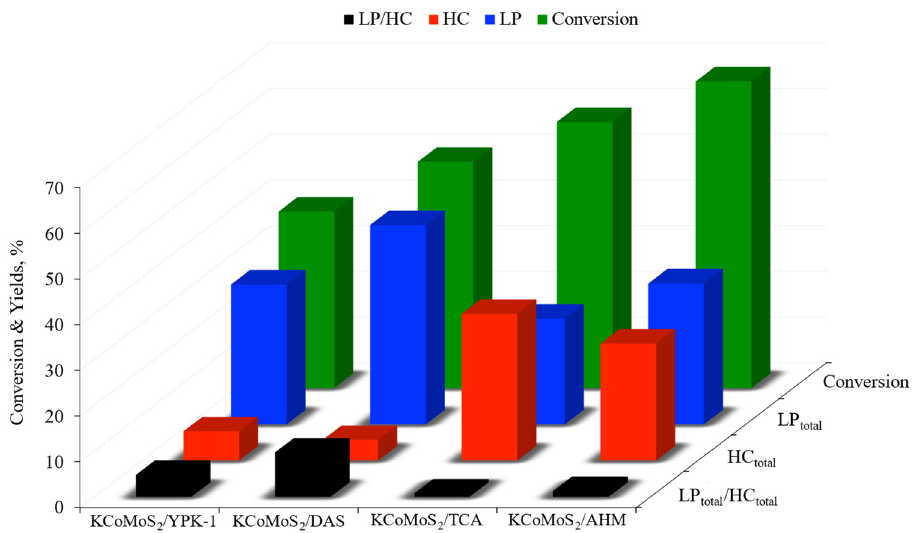
Figure 4. Dependence of total liquid product yields (LP total ) and hydrocarbon (HC total ) yields on conversion. Reaction conditions: T = 320 °C, m cat = 3 g, P = 2.5 MPa, GHSV = 760 L h –1 kg cat–1 , and feed flow rate = 0.3 mL/min under He atmosphere.